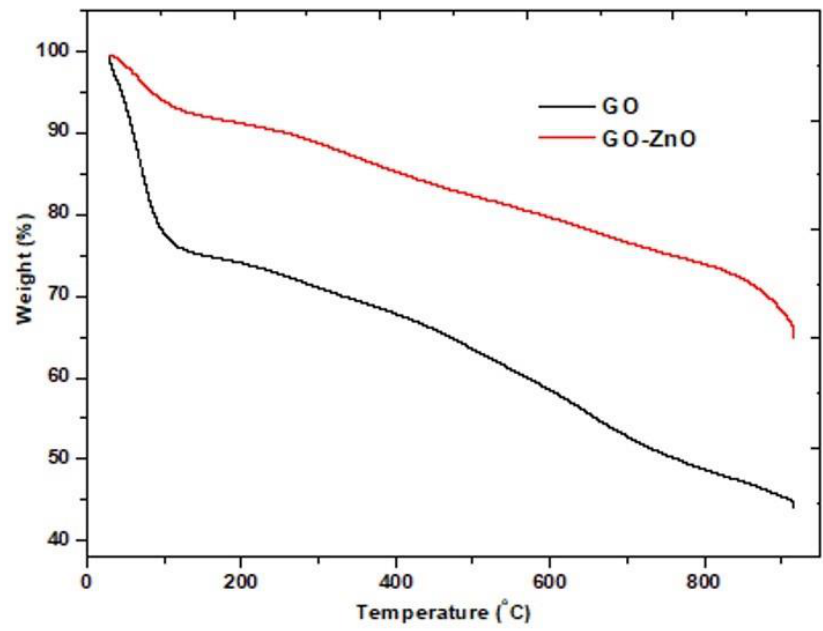
Figure 7. TGA for the natural waste based GO and